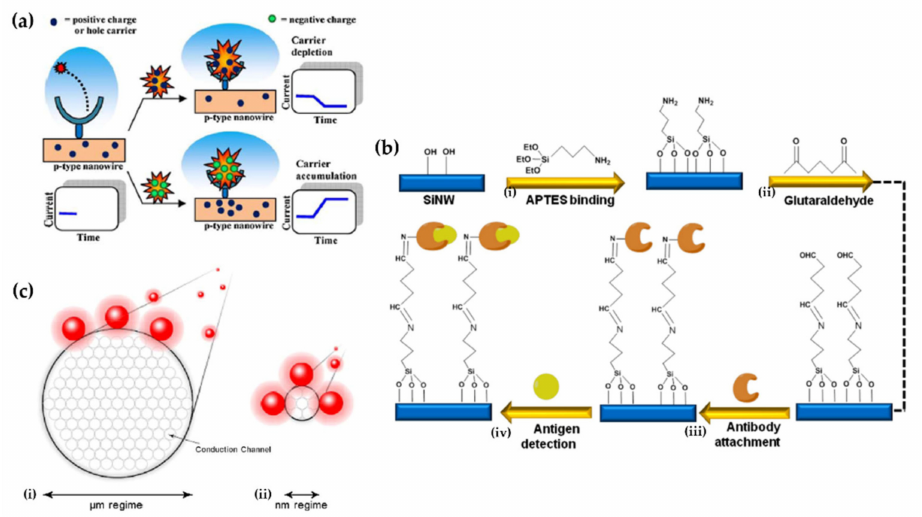
Figure 4. Silicon-nanowire-field-effect-transistor-based (SiNW-FET) immunosensors. ( a ) Schematic representation of the conductance change in a SiNW-FET-based immunosensor as a function of the target molecule charge. Adapted from [123] with permission from Elsevier. ( b ) Schematic representation of the chemical process involved in the modification of silicon nanowire (SiNW) surface: ( i ) Binding of 3-aminopropyl triethoxysilane (APTES) to SiNW, ( ii ) addition of bifunctional linker glutaraldehyde and ( iii ) antibody attachment, and ( iv ) antigen detection. Adapted from [124] with permission from Springer Nature. ( c ) Schematic representation of how the diameter of a wire affects the change in its conductance: ( i ) for thick wires, the surface-to-volume ratio is relatively small. When the wire surface is approached by charged particles (red ball), only the conductance near the wire surface is affected. There is still a large interior area of the wire that might not be influenced (gray circle). ( ii ) As the wire diameter is reduced to the nanoscale, the surface-to-volume ratio drastically increases. Therefore, the same external electrical field (pink area) caused by the charged particles (red ball) could influence most of the inner region of the nanowire, thus drastically changing its conductance. Adapted from [123] with permission from